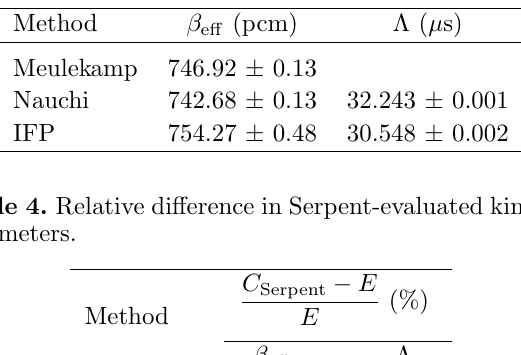
Table 3. Serpent-evaluated kinetics parameters.